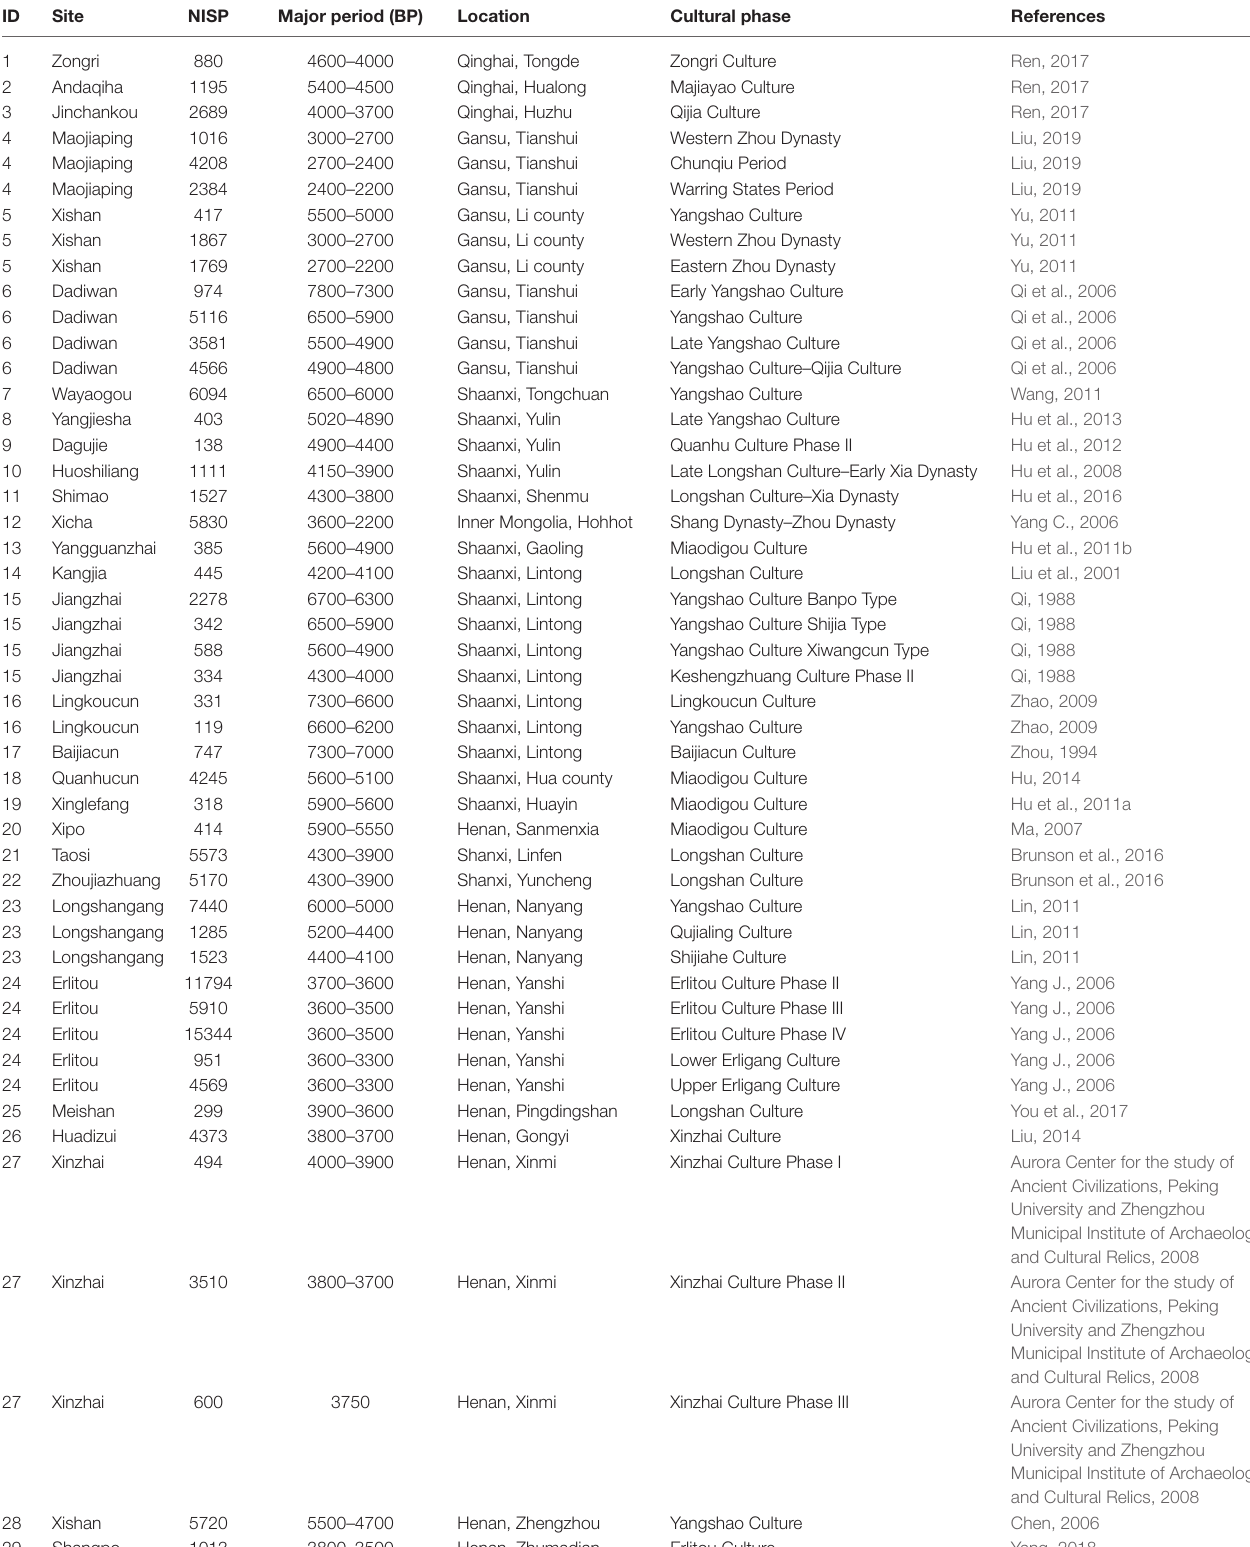
TABLE 1 | Names, NISP (Number of Identified Specimen), major periods, locations, cultural phases, and references of all sites included in this